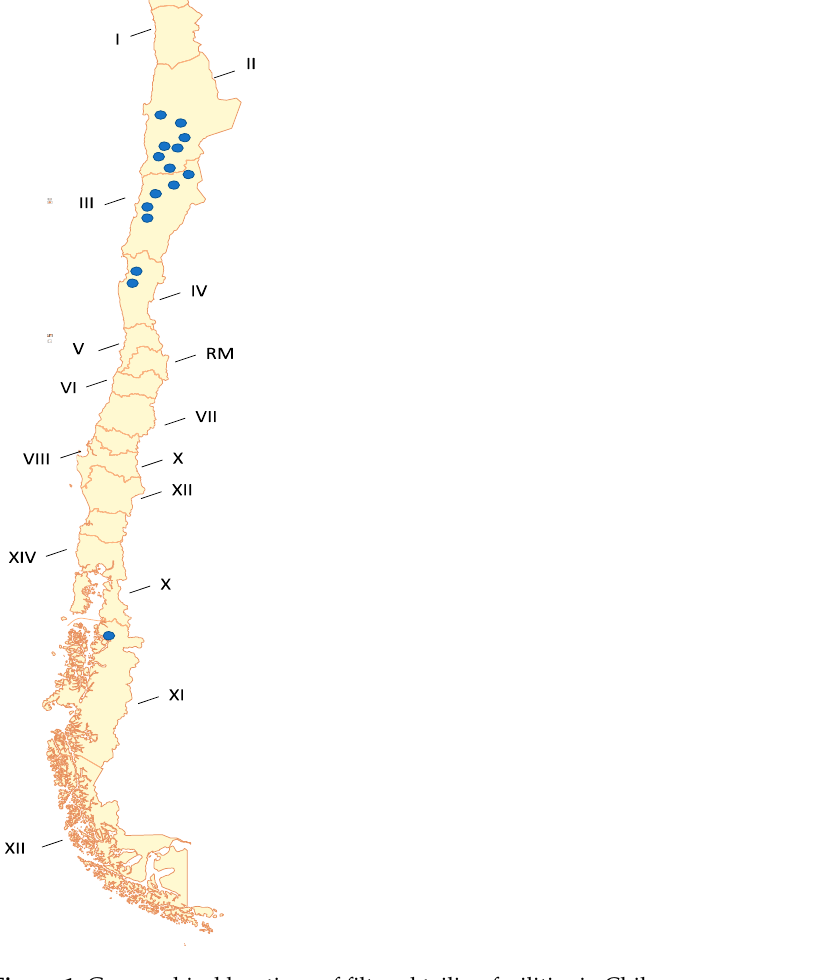
Figure 1. Geographical locations of filtered tailing facilities in